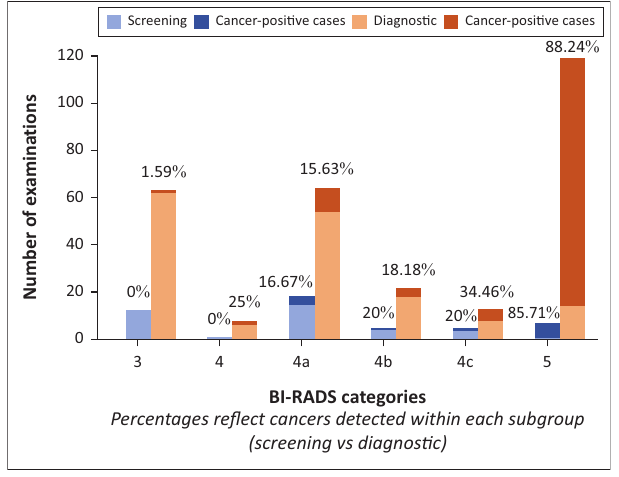
FIGURE 1: Breast-imaging reporting and data system categories and cancers detected for abnormal interpretations in screening and diagnostic